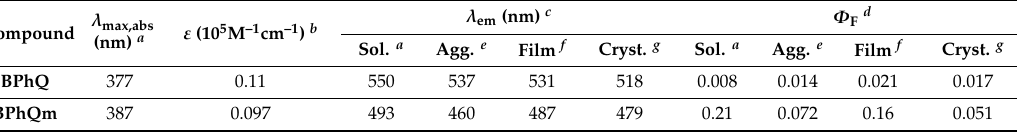
Table 1. Optical properties of the synthesized compounds.